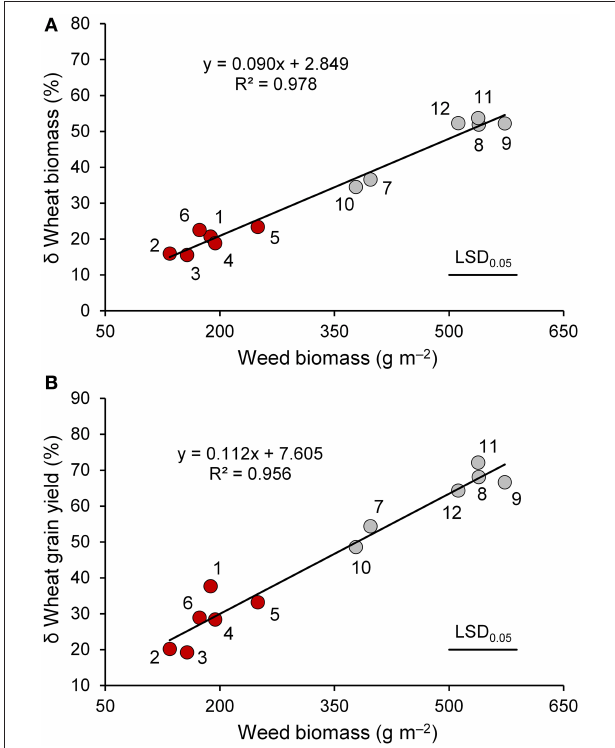
FIGURE 3 | The relationship between weed biomass and percent variation in biomass (A) and grain yield (B) of wheat genotypes (red circle, “old” genotypes; gray circles, “modern” varieties) in the presence of interspecific competition with respect to the absence of competition at maturity. 1, Biancuccia; 2, Maiorcone; 3, Realforte; 4, Russello; 5, Scorsonera; 6, Cappelli; 7, Capeiti; 8, Creso; 9, Simeto; 10, Valbelice; 11, Iride; 12,